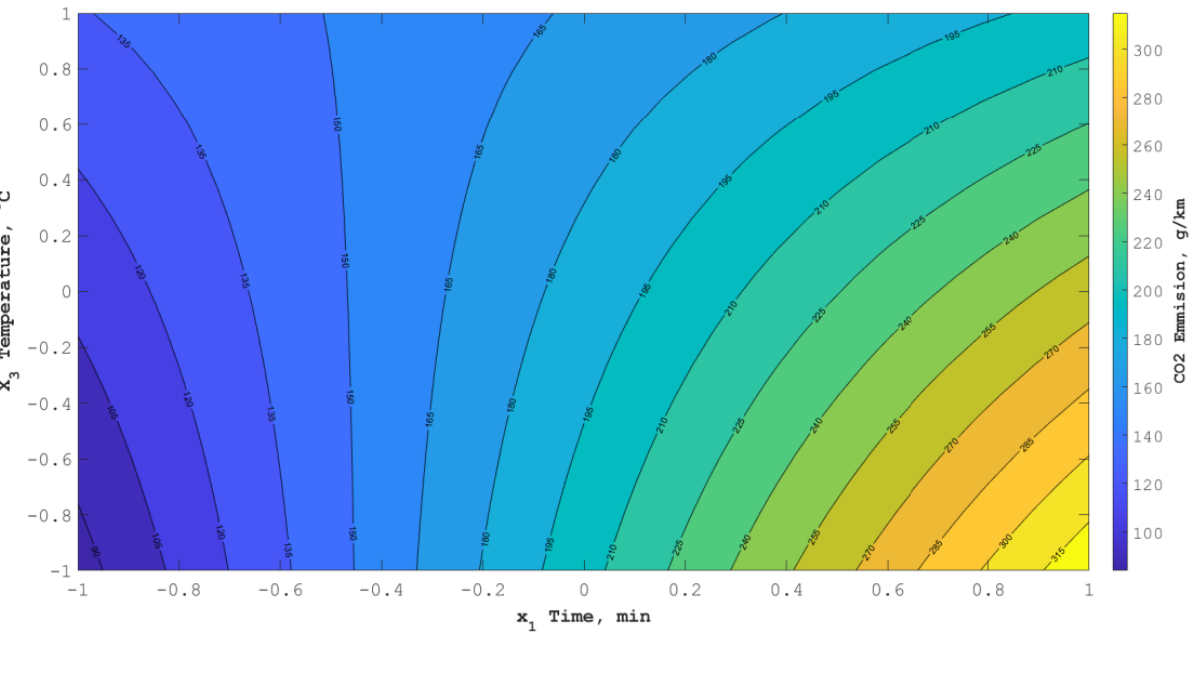
Figure 14. Change in CO 2 emissions depending on the variability of factors x 1 and x 3 for a vehicle (EV) covering a distance of 2 km (x 2 = −1 ).